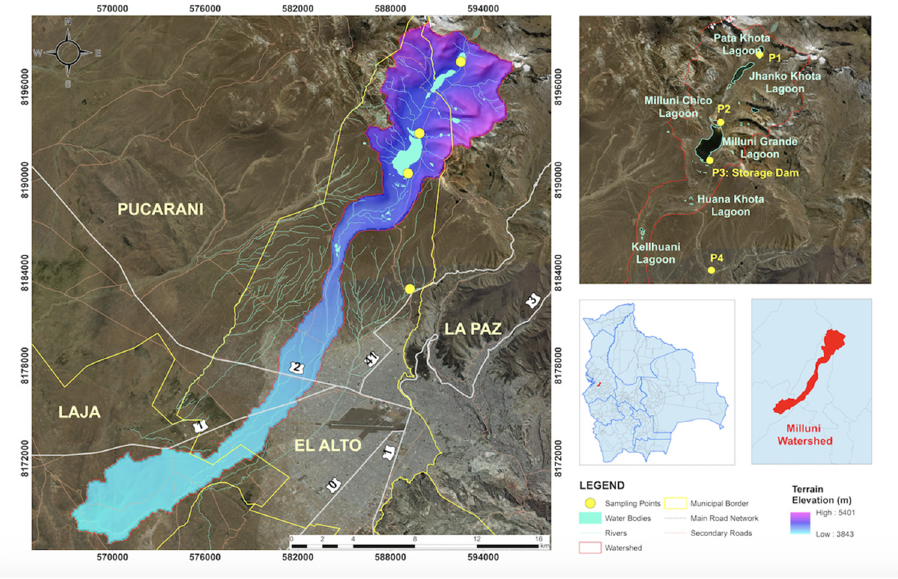
Figure 2. Location of the micro-basin and distribution of the monitored points. Source: Own elaboration, 2021.